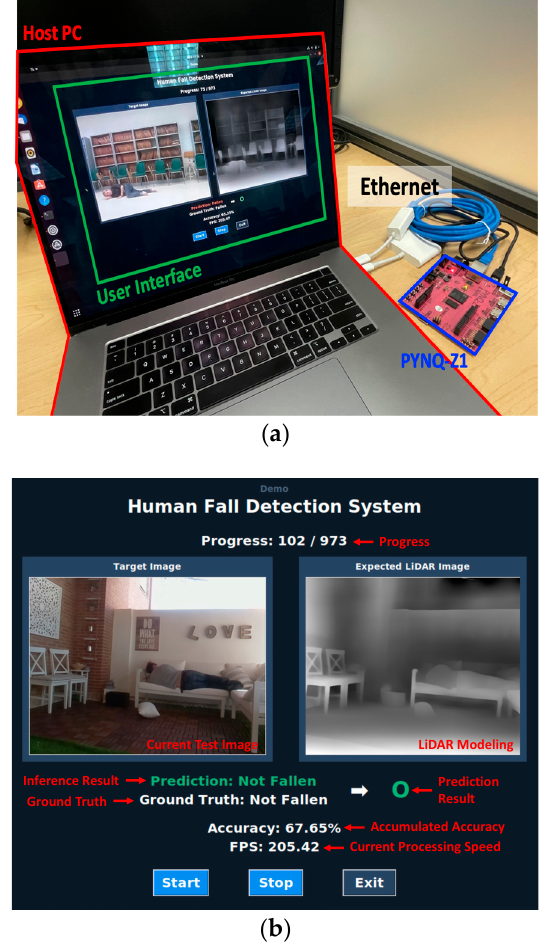
Figure 14. ( a ) User interface of demonstration system and ( b ) demonstration system.